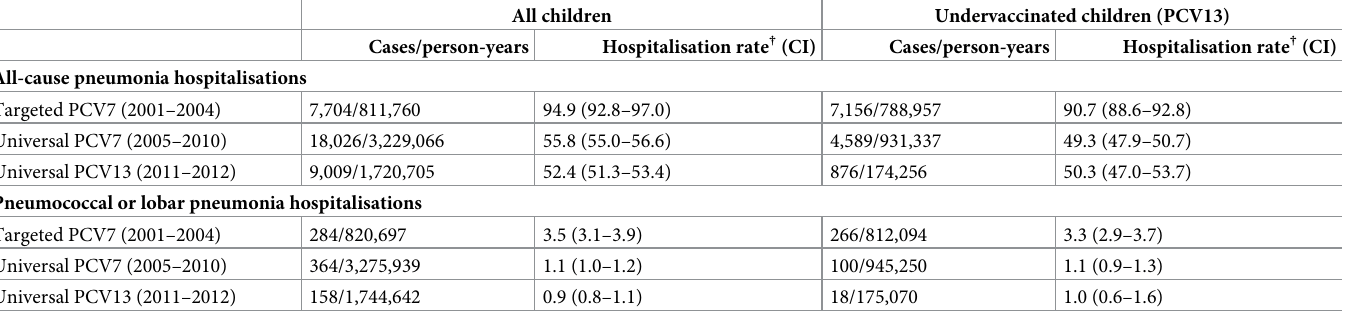
Table 3. Rates of pneumonia hospitalisations among all children and undervaccinated children � , New South Wales and Western Australia by vaccination period, 2001–2012.